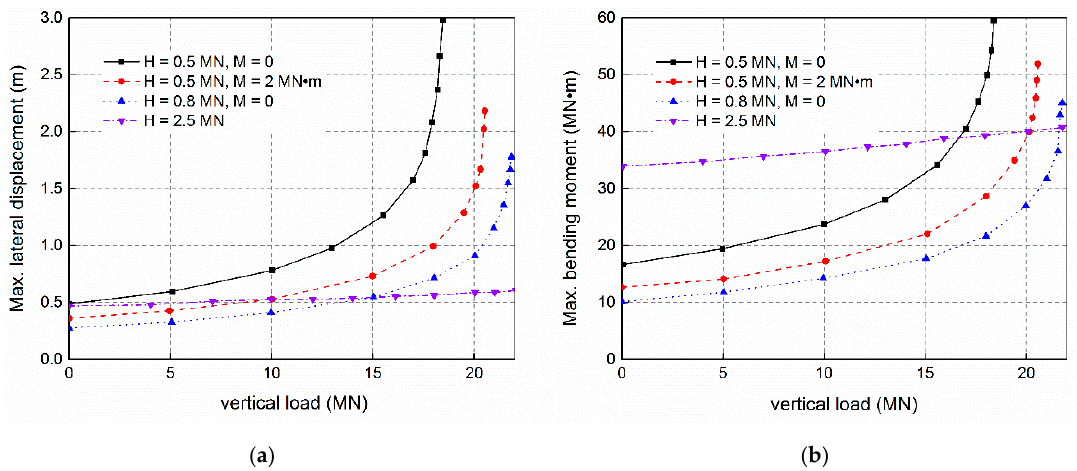
Figure 2. Variation in lateral response features of piles under increasing vertical loads (reproduced from Zhang et al. [21]) ( a ) maximum lateral displacement, ( b ) maximum bending moment .